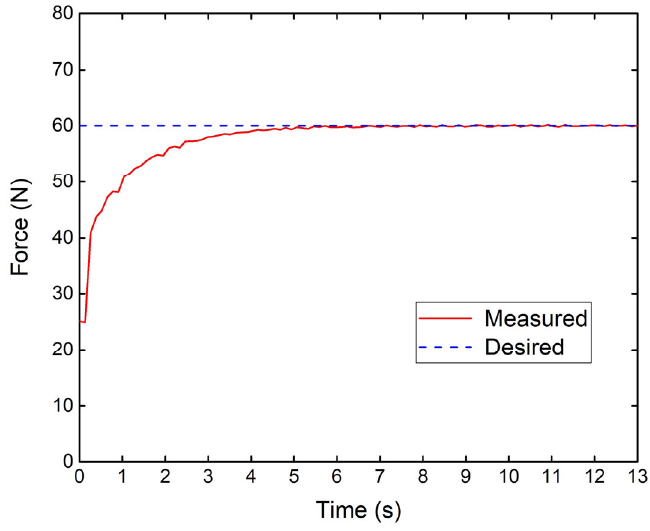
Figure 10. Tracking response curve of PID control.